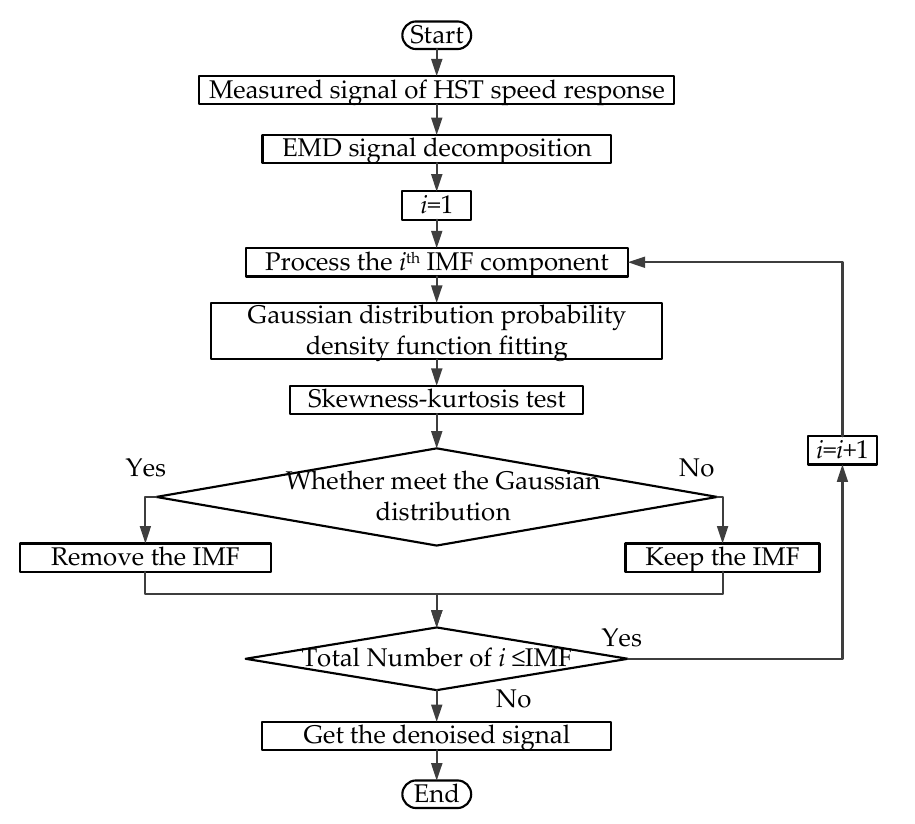
Figure 6. The diagram of the proposed denoising method.